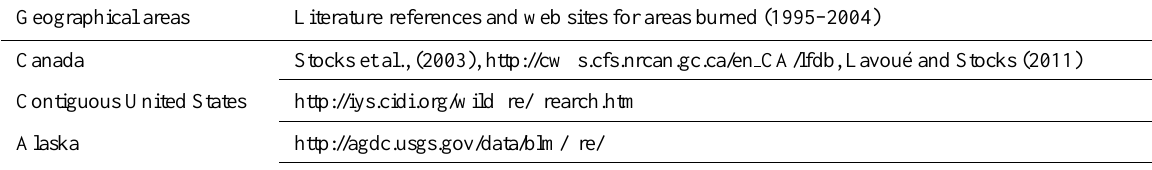
Table 1. Literature references and web sites visited to get areas burned by countries in different geographical areas between 1995 and 2004. Geographical areas